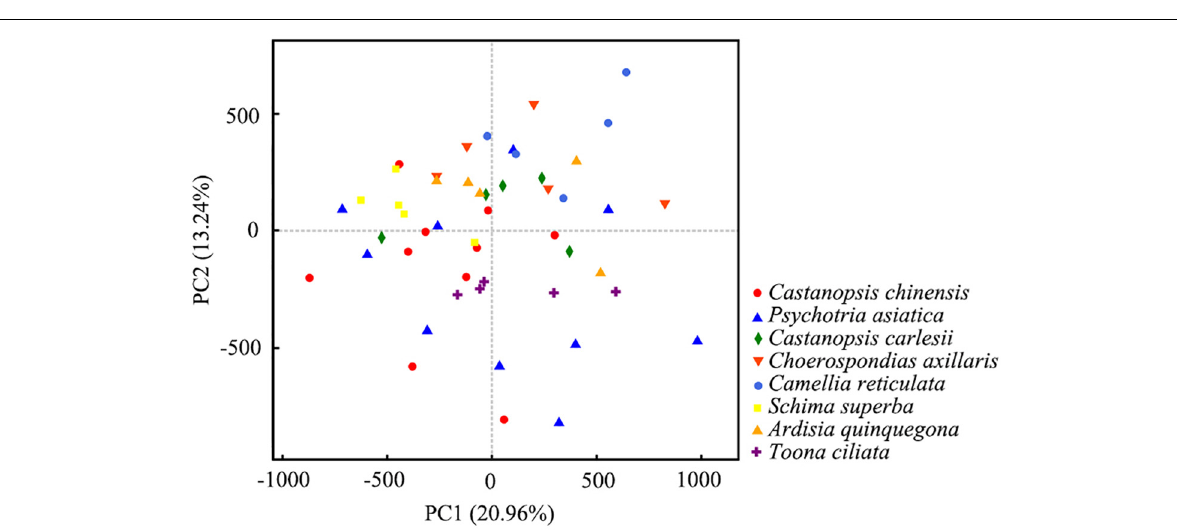
FIGURE 7 | Principle component analysis (PCA) plot of the host plant and soil bacterial communities’ richness. The values of PC1 and PC2, explaining 20.96 and 13.24% of the